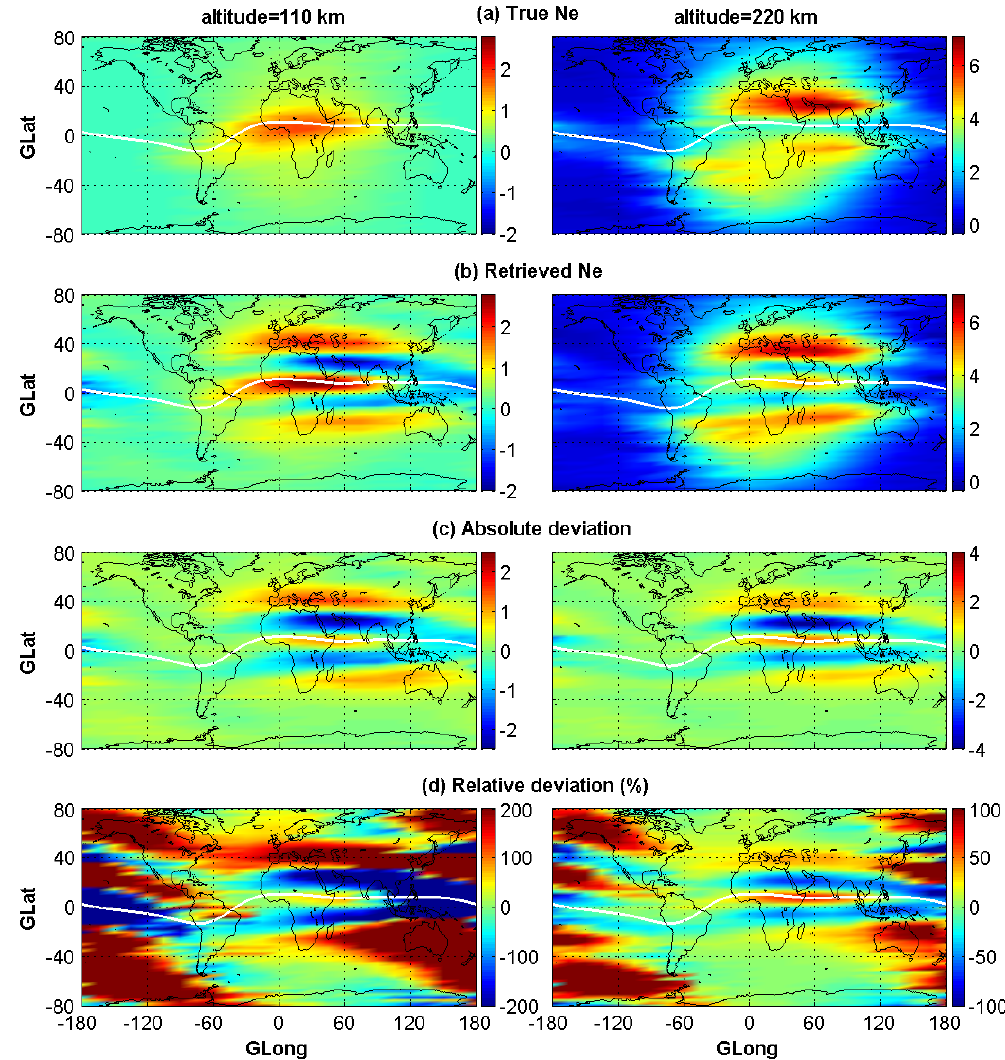
Fig. 3. Geographic longitudinal and latitudinal variations of true electron density (a) , retrieved electron density (b) , absolute deviations (c) and relative deviations (d) between retrieved and true electron density during 10:00–12:00UT. Left and right panels are for 110 and 220km altitudes. The white lines indicate the DIP equator. The unit in panels (a–c) is 10 11 m − 3 and in panels (d) is